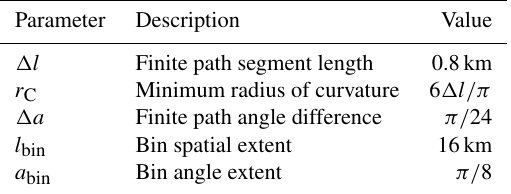
Table 1. Parameters and values in the centreline mapping algorithm as applied to the area of interest presented in Fig. 3